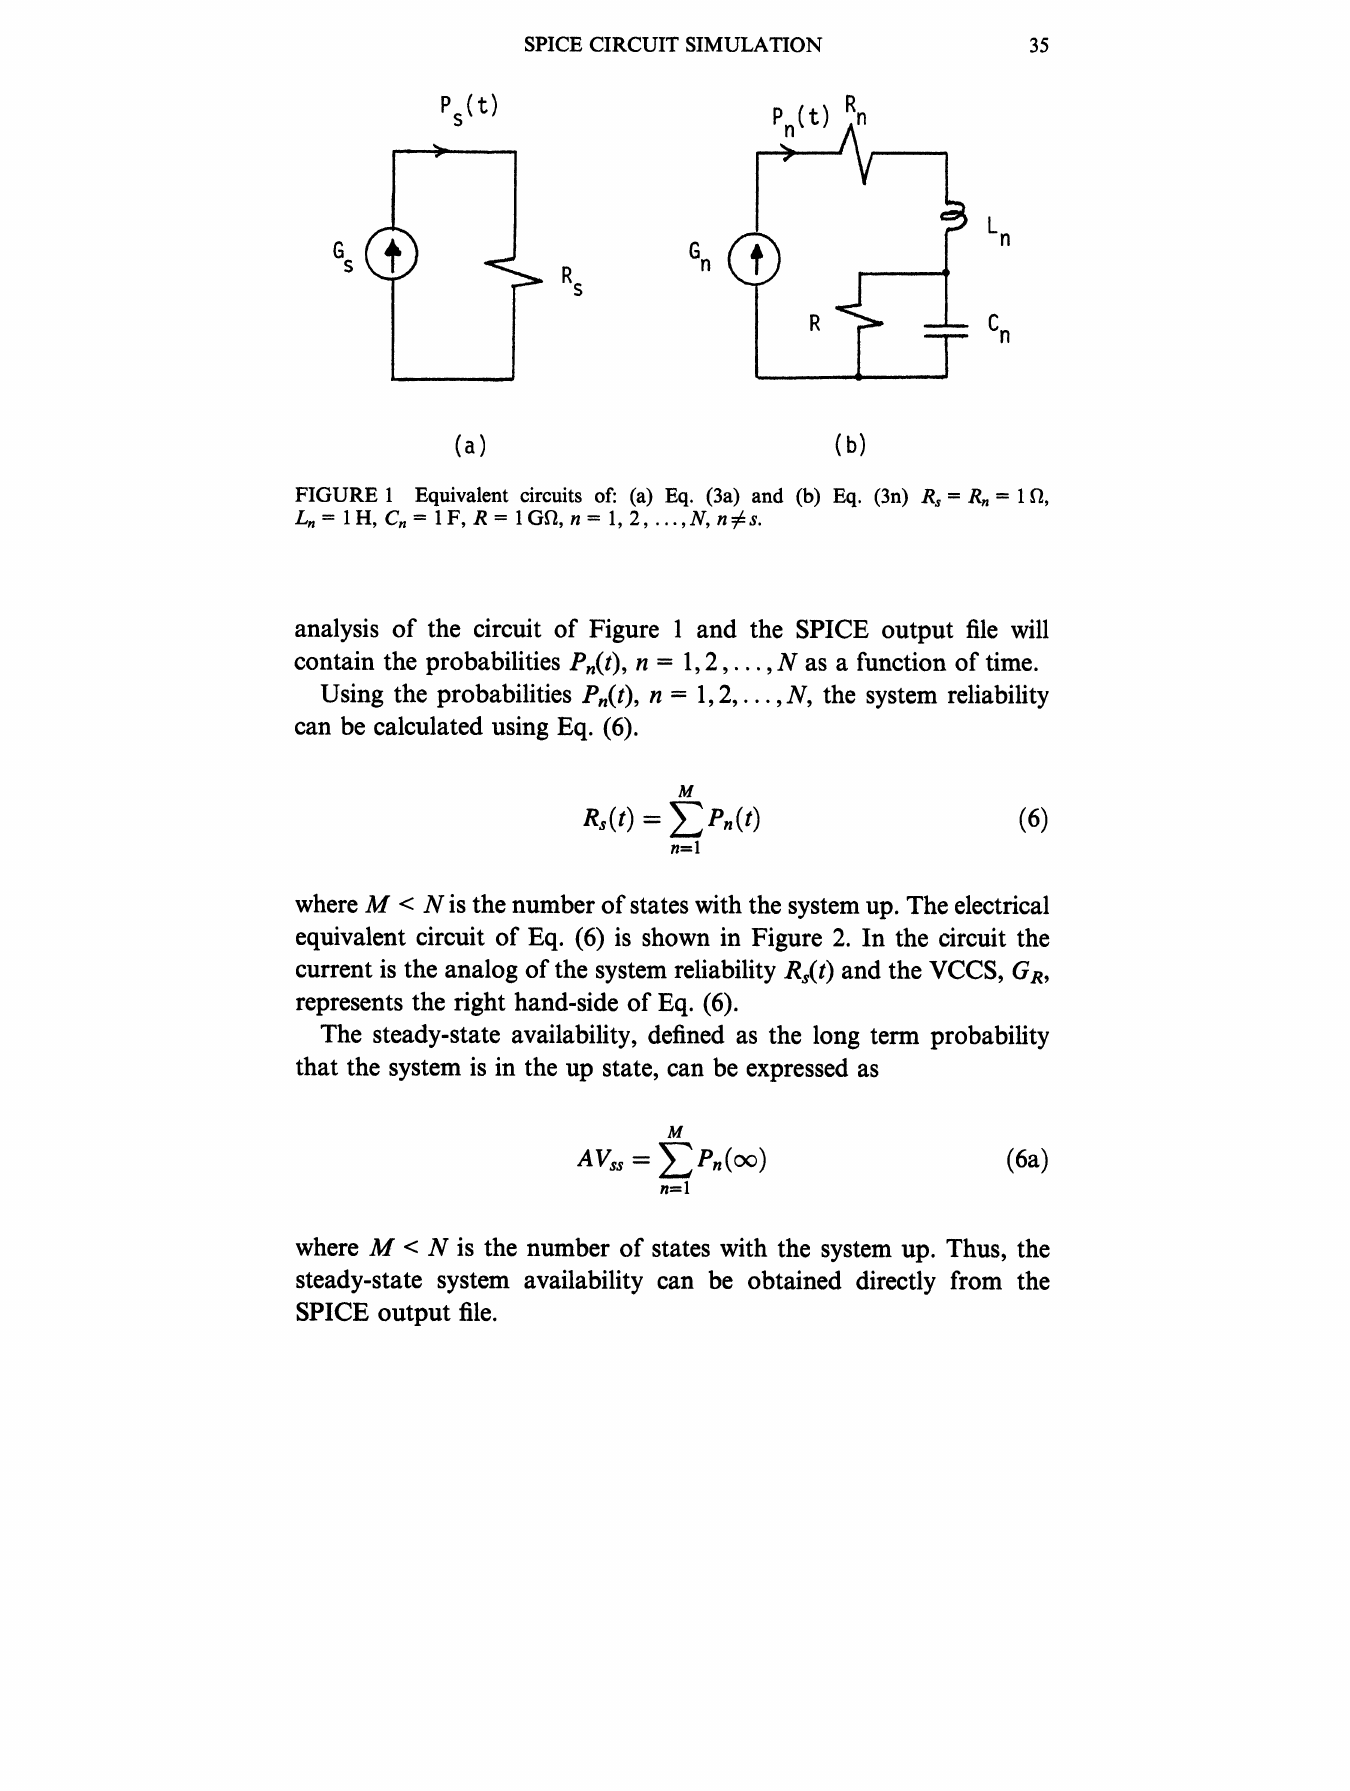
FIGURE Equivalent circuits of." (a) Eq. (3a) and (b) Eq. (3n) R R, f, L,= 1H, C, IF, R= IGf, n= I, 2 N,ns.